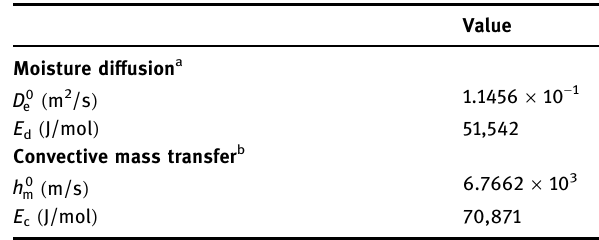
Table 5: Activation energy for moisture di ff usion and for convective mass transfer of thistle fl